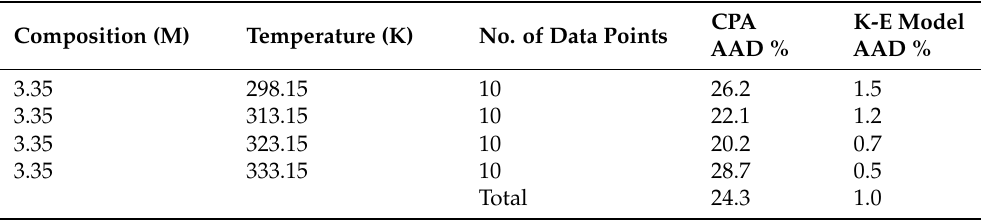
Table 11. Percentage average absolute deviations (AAD %) of models’ correlations form the experi- mental data of this study for the CO 2 loading of MAPA